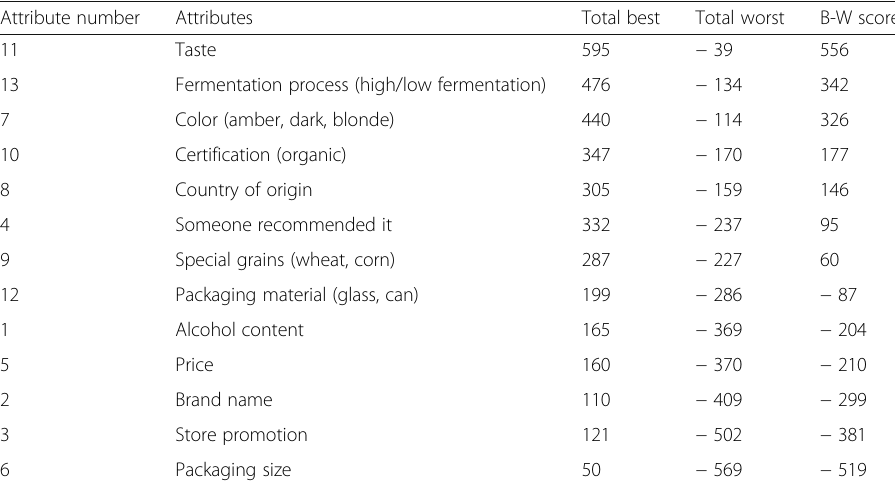
Table 5 Importance of craft beer attributes by respondents (ranked by B-W